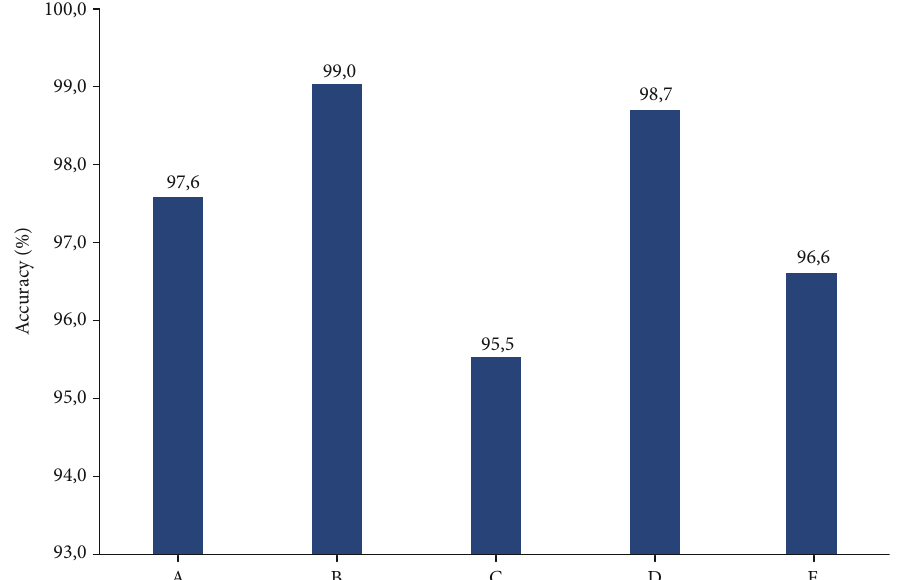
Figure 6: MS prediction accuracy using the KNN model with fi ve randomly selected cytokines commonly expressed in patient serum as input. Serum common cytokines dataset consists of ten cytokines (IL-1 α , IL-4, IL-18, CCL7, CCL27, INF γ , LIF, M-CSF, SCF, and TNF α ). A: (IL-4, IL-18, CCL27, M-CSF, and SCF); B: (IL-4, CCL7, CCL27, INF γ , and SCF); C: (IL-1 α , IL-18, INF γ , M-CSF, and TNF α ); D: (IL-1 α , IL-4, CCL27, INF- γ , and M-CSF); and E (IL-1 α , IL-4, IL-18, LIF, and M-CSF) are datasets which are generated by considering fi ve random cytokines. The accuracy is the average of 15 runs.